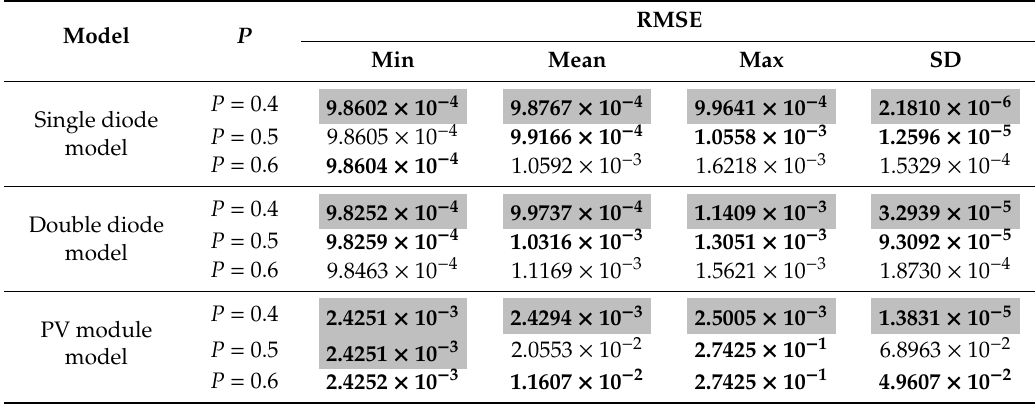
Table 6. Statistical results of root mean square error (RMSE) of IMFO with di ff erent settings of P on the three